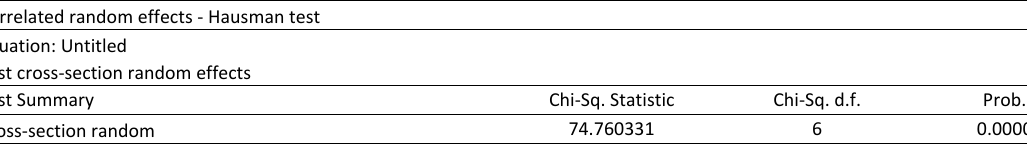
Table 2: Results of hausman test